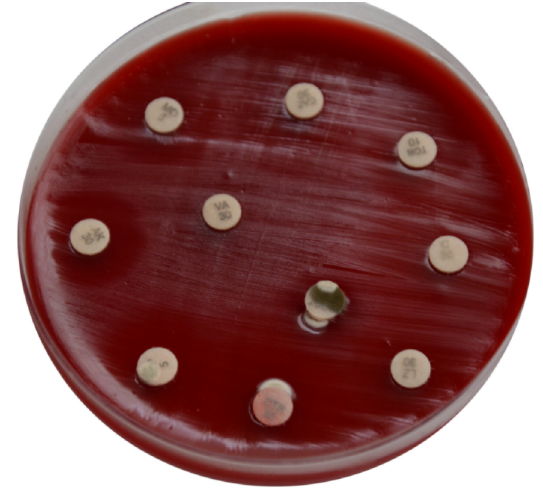
Figure 4: Antibiotic sensitivity of Moraxella for amikacin, ceftriaxone, ceftazidime, chloramphenicol, tobramycin, vancomycin and linezolid on blood agar with the Kirby-Bauer disc diffusion